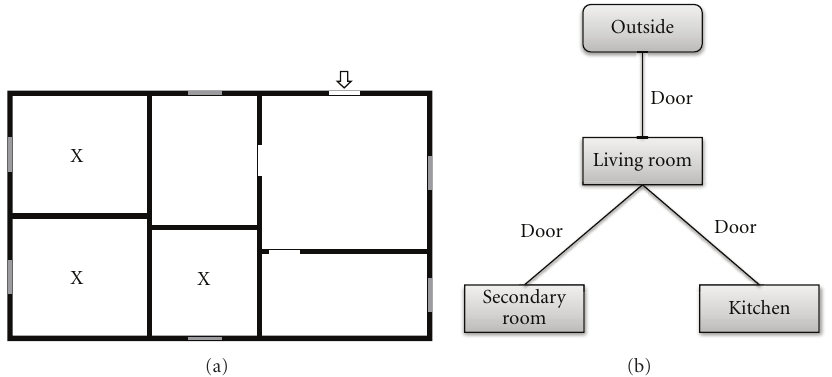
Figure 12: Example of floor plan (a) containing 3 nonconnected rooms (labeled with X) and its respective connectivity graph (b).